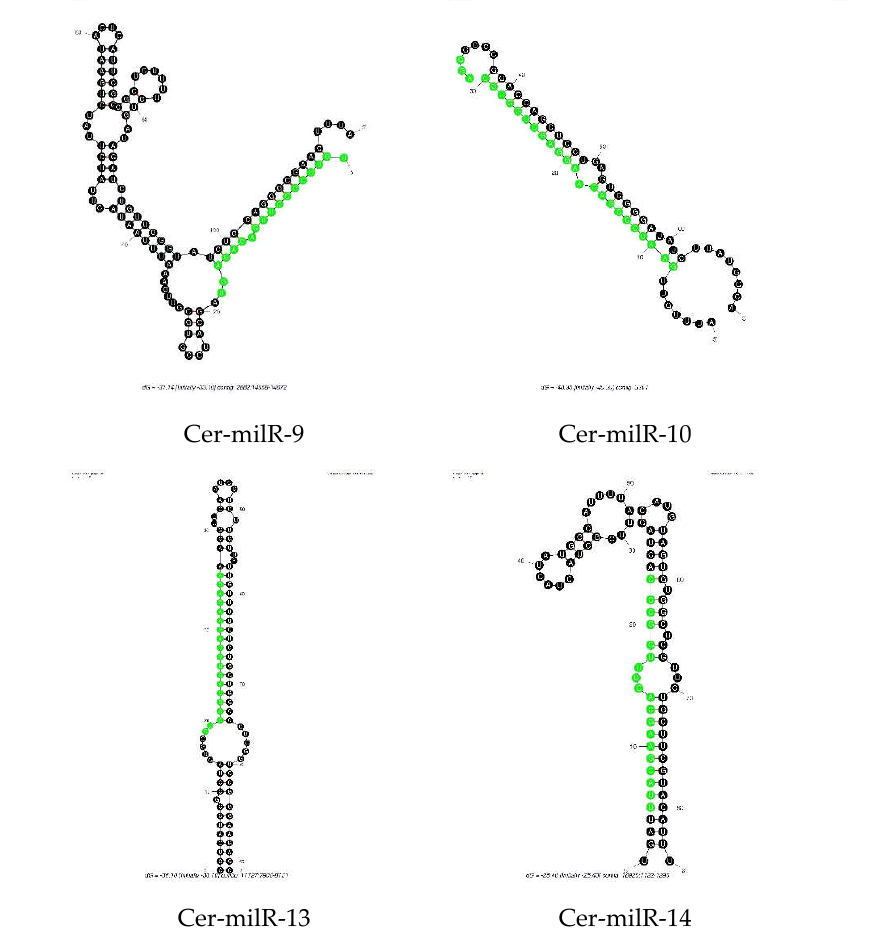
Figure 4. Prediction of hairpin structures of Ceratobasidium C02 pre-milRNAs. The secondary structures were processed with the Mfold application with default parameters. The sequences of possible milRNAs are highlighted in green.